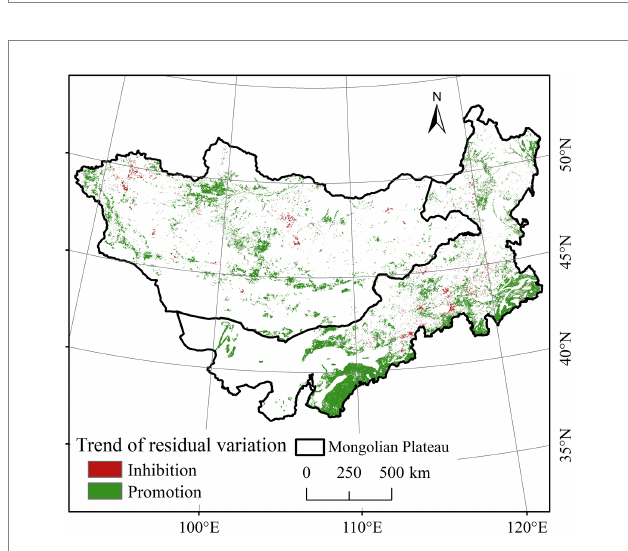
FIGURE 7 Trend distribution of NDVI residuals on the Mongolian Plateau from